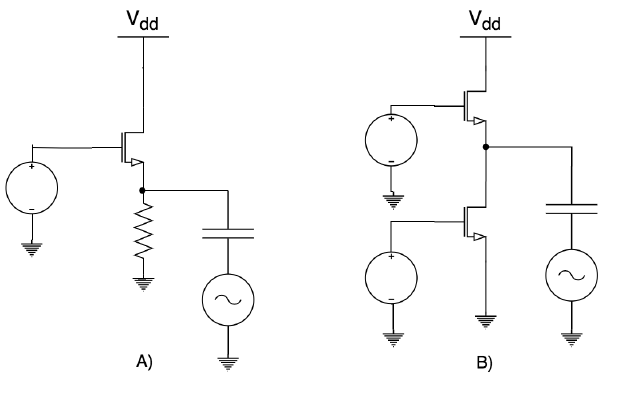
Figure 10. Schematics of the common drain stage, with passive ( A ) and active ( B ) load respectively.